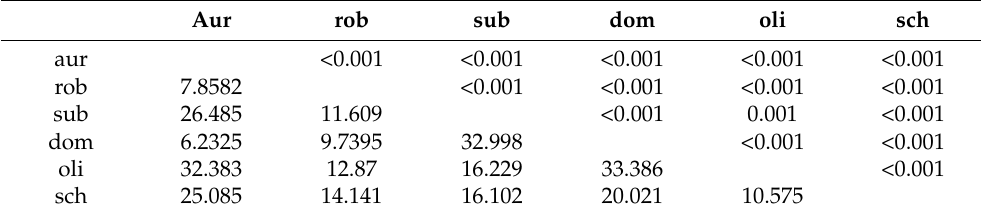
Table 6. Squared Mahalanobis distances (below the diagonal) and p -values (above the diagonal) among the six examined species. All values are significant, suggesting complete morphological sorting among species. Abbreviations: aur = C. aurantiaca ; rob = C. robusta ; sub = C. subroseophylla ; dom = C. dominguezii ; oli = C. oliversacksii ; sch = C. schiblii . Aur rob sub dom oli sch aur <0.001 <0.001 <0.001 <0.001 <0.001 <0.001 <0.001